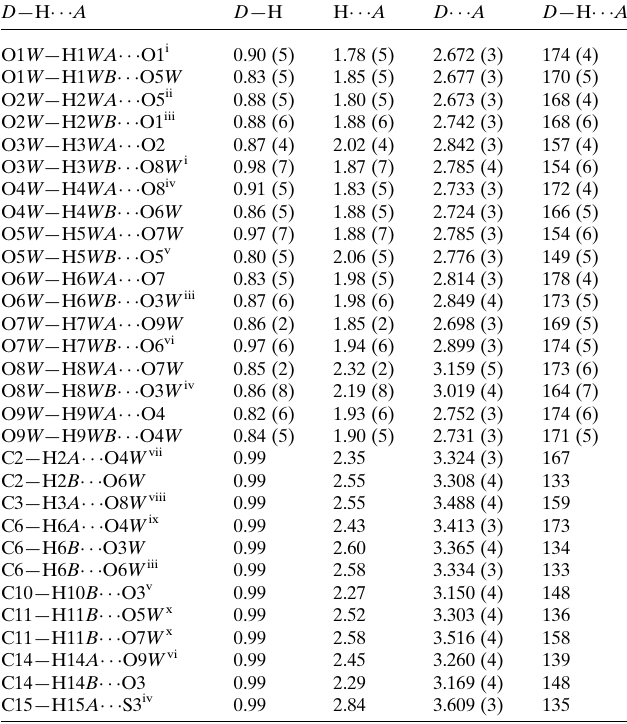
Table 1. There is a slight difference in the Ni—N bond lengths